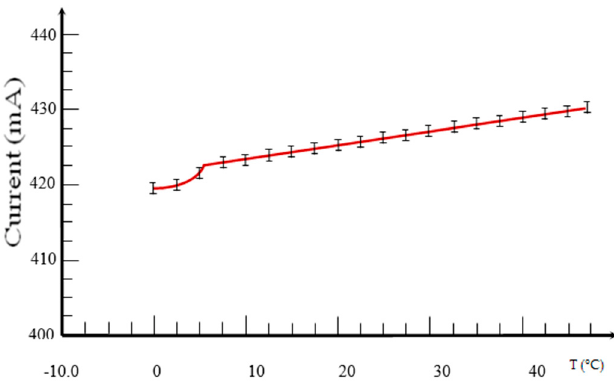
Figure 13. Current consumption as a function of the variation of the CPU temperature.